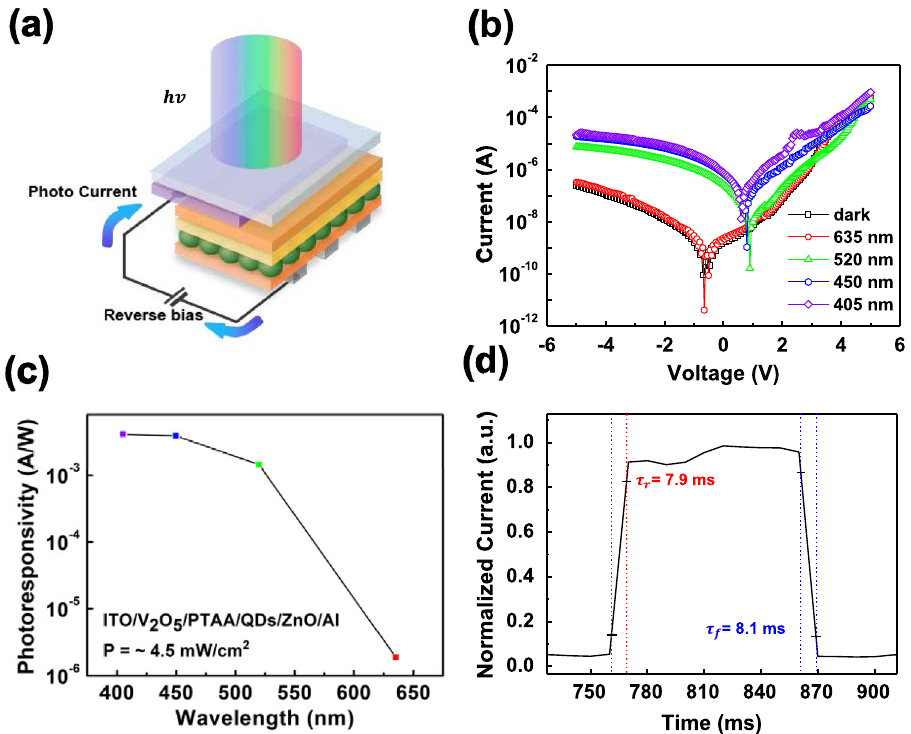
Figure 6. ( a ) Schematic structure of the PDs. ( b ) I-V of the device in the dark state and under various light wavelengths. ( c ) Photoresponsivity of the PD at 635, 520, 450, and 405 nm light wavelengths. ( d ) Photo response characteristics of PD. The rising and falling times were defined at the interval between 10 and 90% of the